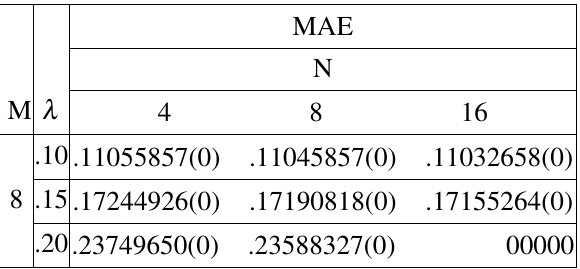
Table 5 Maximum absolute error (Problem